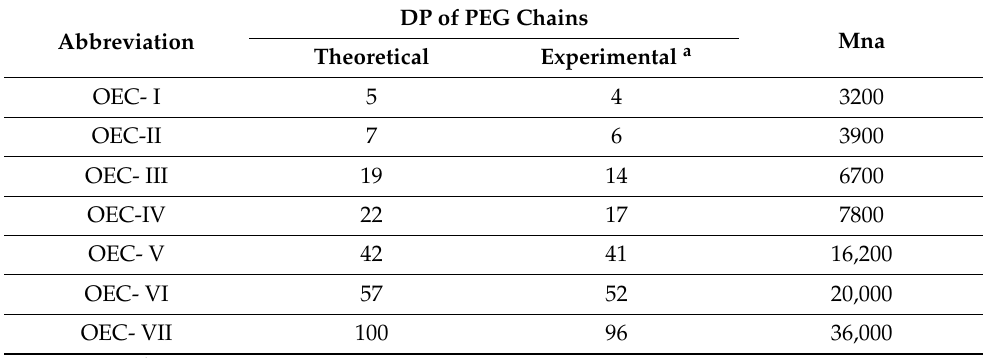
Figure 2. Schematic representation of the synthesis of PEGylated tert -octylcalix[8]arenes. The polymerization degrees of the PEG fragments and the corresponding average molar masses of the obtained PEGylated tert -octylcalix[8]arenes were determined from the relative areas of the signals of the CH 2 groups of the PEG fragments at 3.5–3.7 ppm, and the CH 3 protons of the tert-octyl groups at 1.0 ppm. A representative 1 H NMR spectrum is shown in the ESI (Figure S2). The abbreviations of the newly synthesized PEGylated tert -octylcalix[8]arenes, as well as theoretical and experimental degrees of polymerization (DP) of the PEG chains and the number average molar masses (M n ) of the investigated products, are given in Table 1. Static light scattering (SLS) measurements of selected samples showed a very good correlation between the molar masses of the products determined by 1 H NMR spectroscopy and SLS (see below and the ESI, Table S1, Figure S3. Table 1. Abbreviations, theoretical and experimental degrees of polymerization (DP) of the PEG chains and number average molar mass (M n ) of the PEGylated tert -octylcalix[8]arenes.